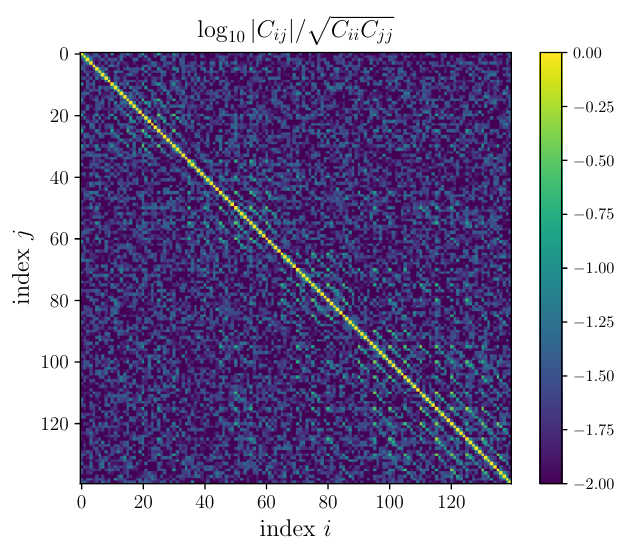
Figure 7. Correlation matrix for the E -mode power spectra estimated from a set of 2000 Gaussian simula-